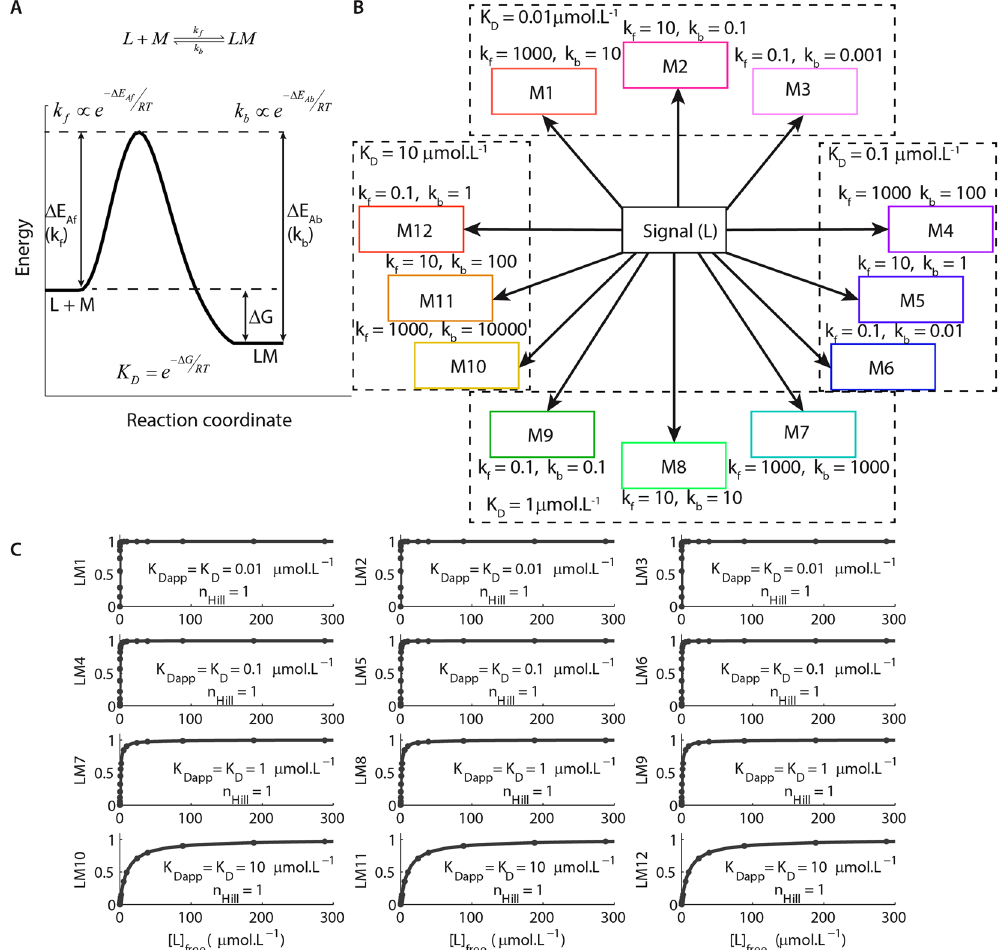
Figure 1. Thermodynamic and kinetic parameter of chemical reactions. ( A ) The energy profile for a simple reversible reaction of complex formation. The species L and M are the initial reactants, LM is the complex formed, k f and k b are the rate constants for the association (forward) and dissociation (backward) reactions, respectively. Δ E Af and Δ E Ab state for the energy of activation for the forward and backward reaction, respectively, R is the ideal gas constant, and T is the temperature in Kelvin. ( B ) Diagram of the simulated system, which consists of twelve different molecules (M1-12) interacting with a ligand (L) with different affinities (K D s) and rate constants (k f s are given in µ mol.L − 1 .s − 1 and k b s in s − 1 ). ( C ) Dose-response curves for the formation of the complex LM1-LM12 as functions of [L] free . The K Dapp s estimated with these curves were set as the control K D s for the formation of LM1-LM12 in our